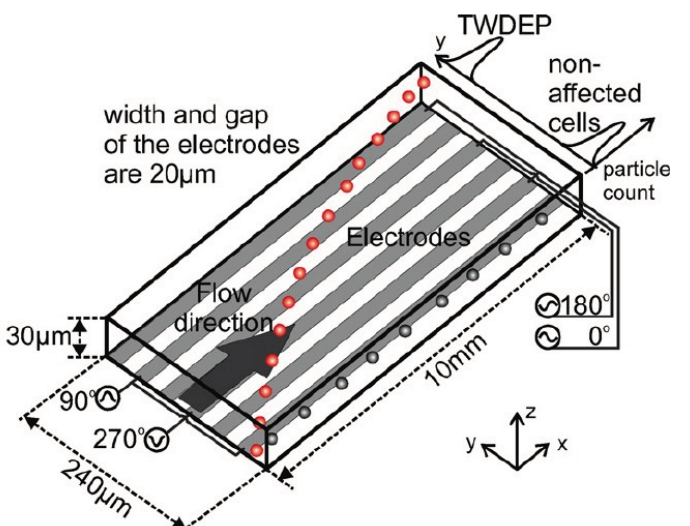
Figure 13. A microchip for biological cells separation base on twDEP [116].